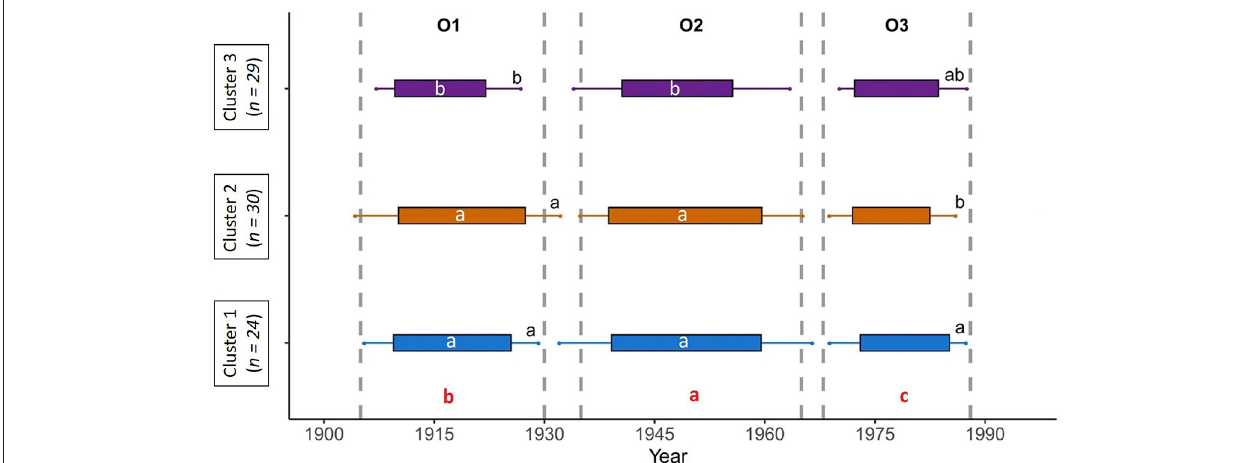
FIGURE 5 | Gantt chart representing the timing of outbreaks for the three clusters. The boxes represent the average duration of outbreaks and the dashes represent the standard deviations of these durations for O1, O2, and O3 in each cluster. Different letters indicate significant differences at p < 0.05 between end dates (black letters) and duration (white letters) for each cluster (a > b). Red letters indicate significant differences in duration, at p < 0.05, between each outbreak (a > b > c). Dotted lines indicate the onset and end dates of each outbreak, according to Navarro et al. (2018).